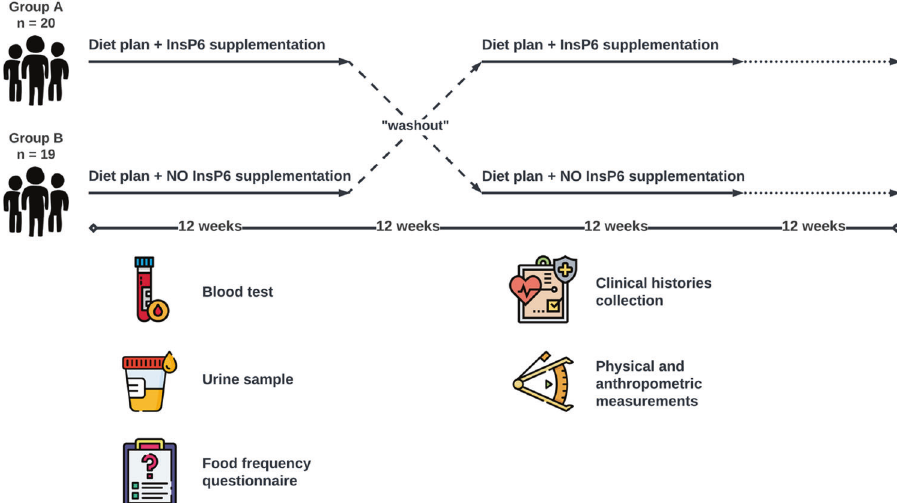
Fig. 1 Subjects were randomly assigned to the InsP6-diet group or to the non-InsP6-diet group for 12 weeks. After 12 weeks, each group was given a 12-week washout period, and then switched to the alternate diet for 12 weeks. All patients were then followed for an additional 12 weeks. Patients received an InsP6 diet (diet plan with InsP6 supplementation) or a non-InsP6 diet (the same diet plan without InsP6 supplementation). Blood test, urine samples, food frequency questionnaire, clinical histories, and physical and anthropometric measurements were prospectively collected during the